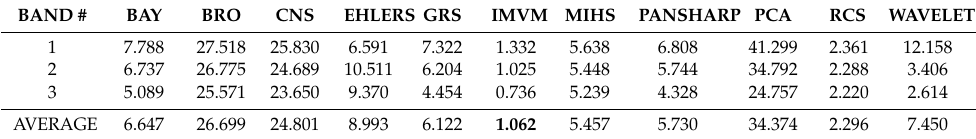
Table 3. Spectral consistency: Erreur Relative Global Adimensionnelle de Synthese (ERGAS).